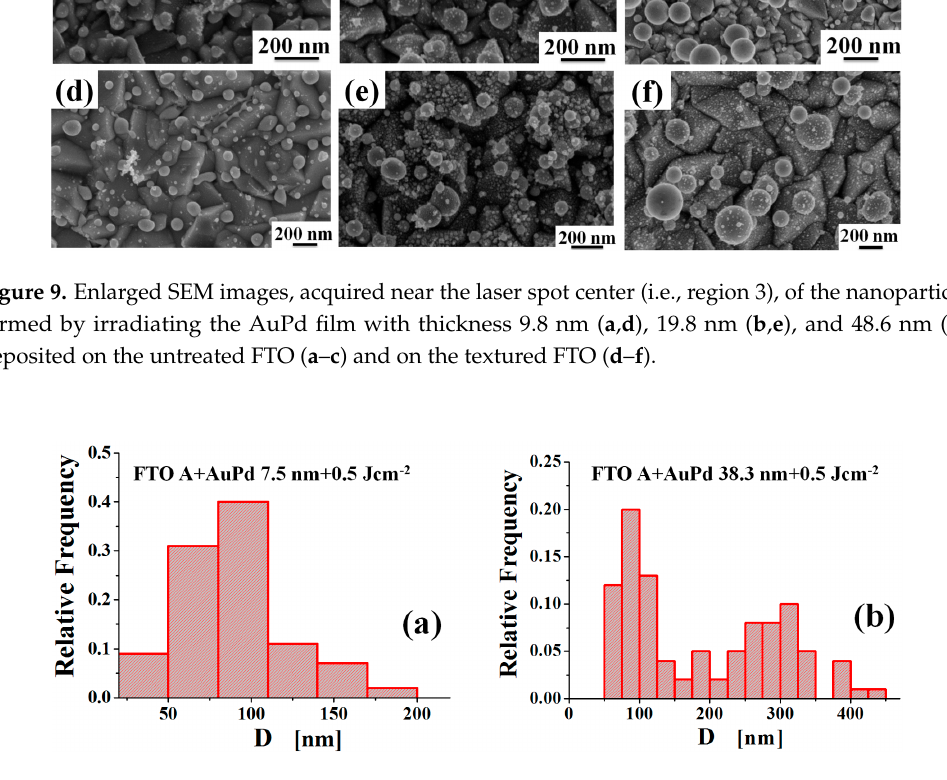
Figure 10. Log-Log plots of the nanoparticles mean diameter < D > as a function of the starting thickness d of deposited AuPd film on the untreated FTO (substrate A, ( a )) and on the textured FTO (substrate B, ( b )).